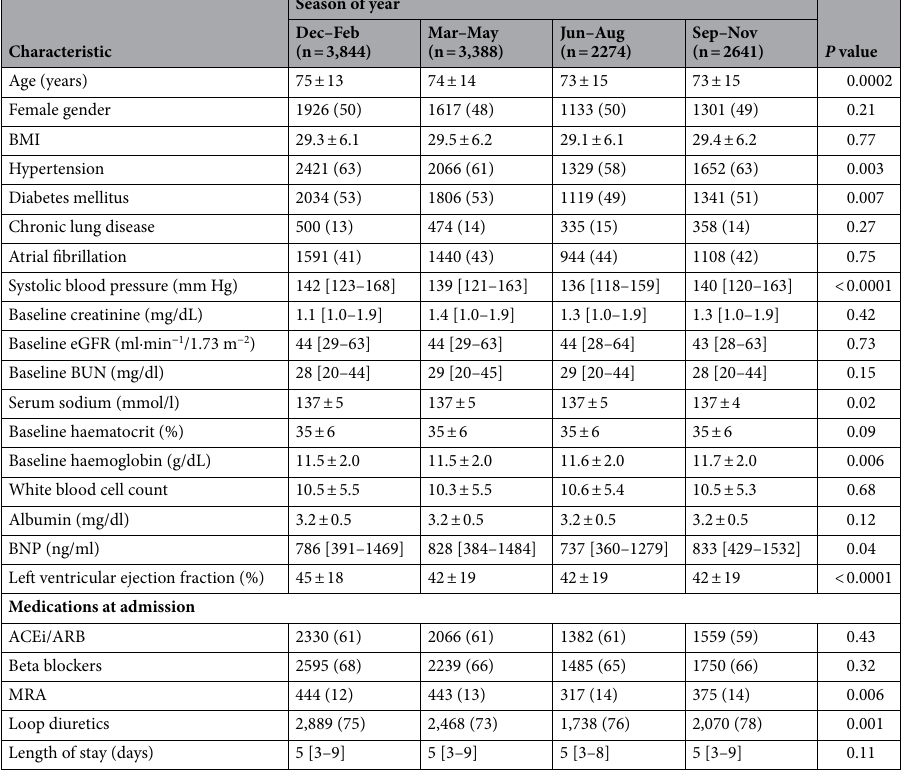
Table 1. Baseline patient characteristics according to time-of-year at admission. ACE angiotensin converting enzyme, ARB angiotensin II receptor blockers, MRA mineralocorticoid receptor antagonist.